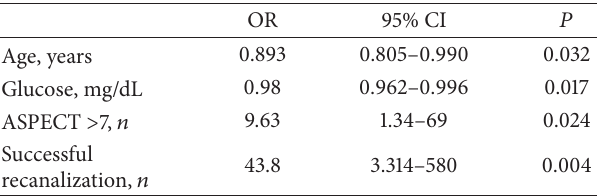
Table4:Resultsoflogisticregressiontofindindependentpredictors of good clinical